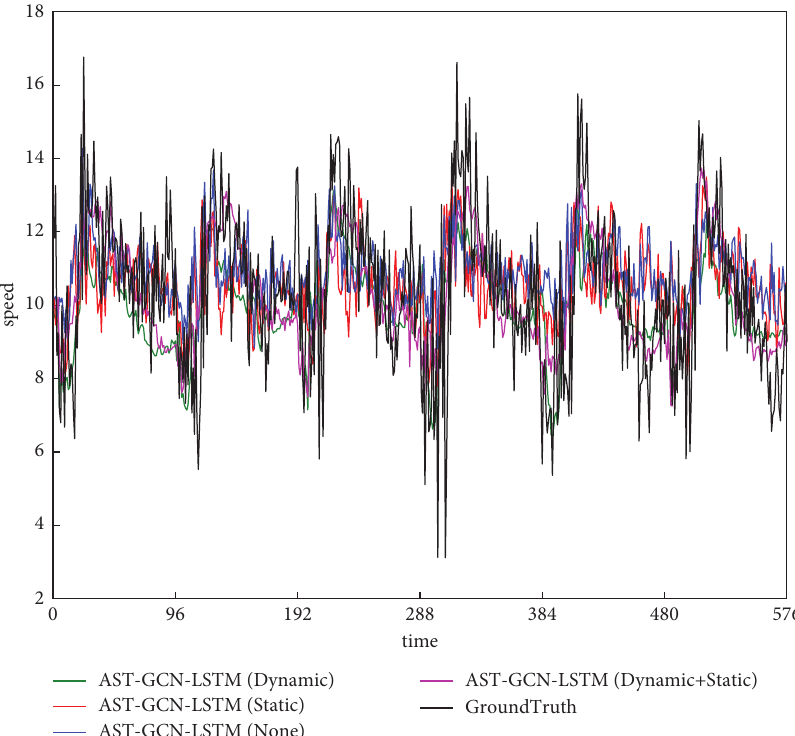
Figure 7: Comparison among forecasting enhanced by different external information. The green line is the dynamic attribute prediction of the model, the red line is the static attribute prediction of the model, the blue line is the model without external attribute prediction, the pink line is the model dynamic and static attribute prediction, and the black line is the real traffic